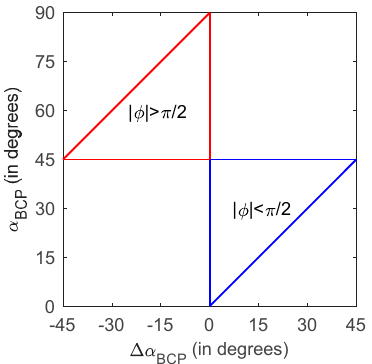
Figure 3. The ∆ α BCP / α BCP plane. Pixels of all CP modes are distributed in the red and blue Figure 3. The ∆𝛼 (cid:2886)(cid:2887)(cid:2900) /𝛼 (cid:2886)(cid:2887)(cid:2900) plane. Pixels of all CP modes are distributed in the red and blue rectangles.